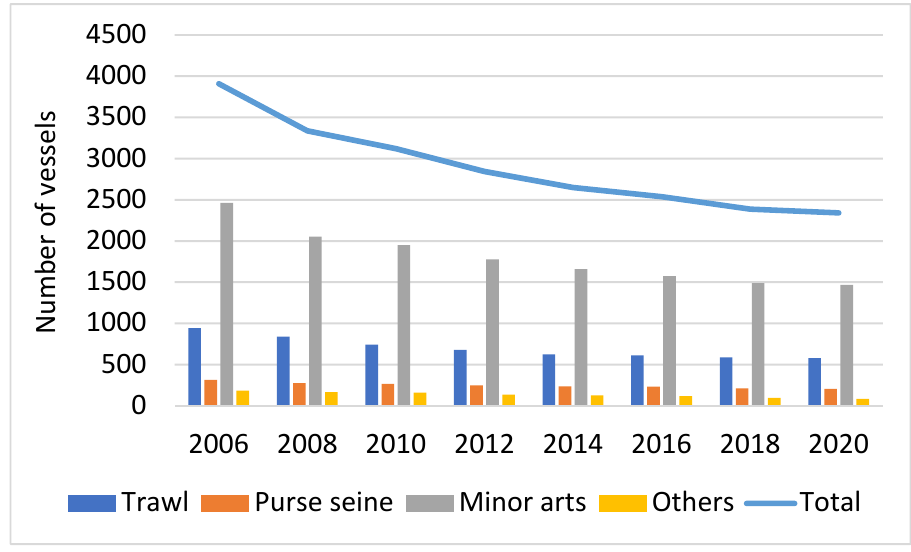
Figure 2. Evolution of the number of fishing vessels (2006–2020) 3 .